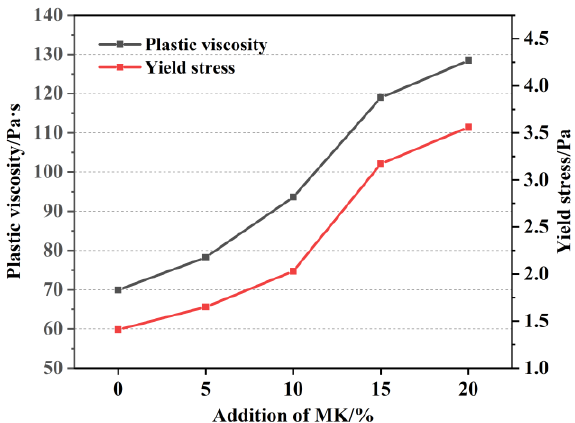
Figure 8. The effect of MK content on MPC T180 value.